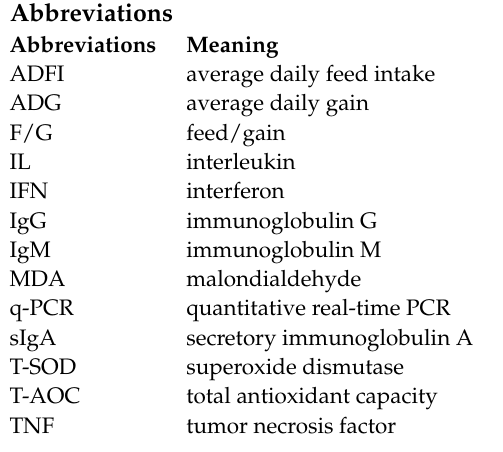
GAPDH; Figure S3: Western Blot Figure for p70; Figure S4: Western Blot Figure for p-akt; Figure S5: Western Blot Figure for